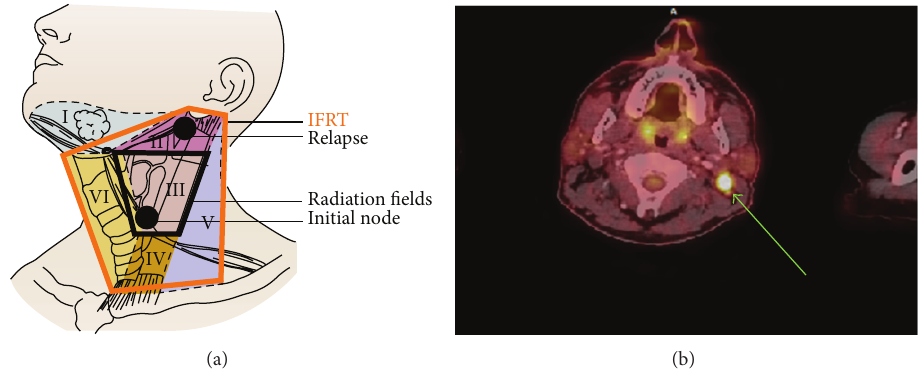
Figure 4: PET scanner showing the relapse in the IIB area and mapping. Table 1: Histological features of NLPHL and cHL [8].